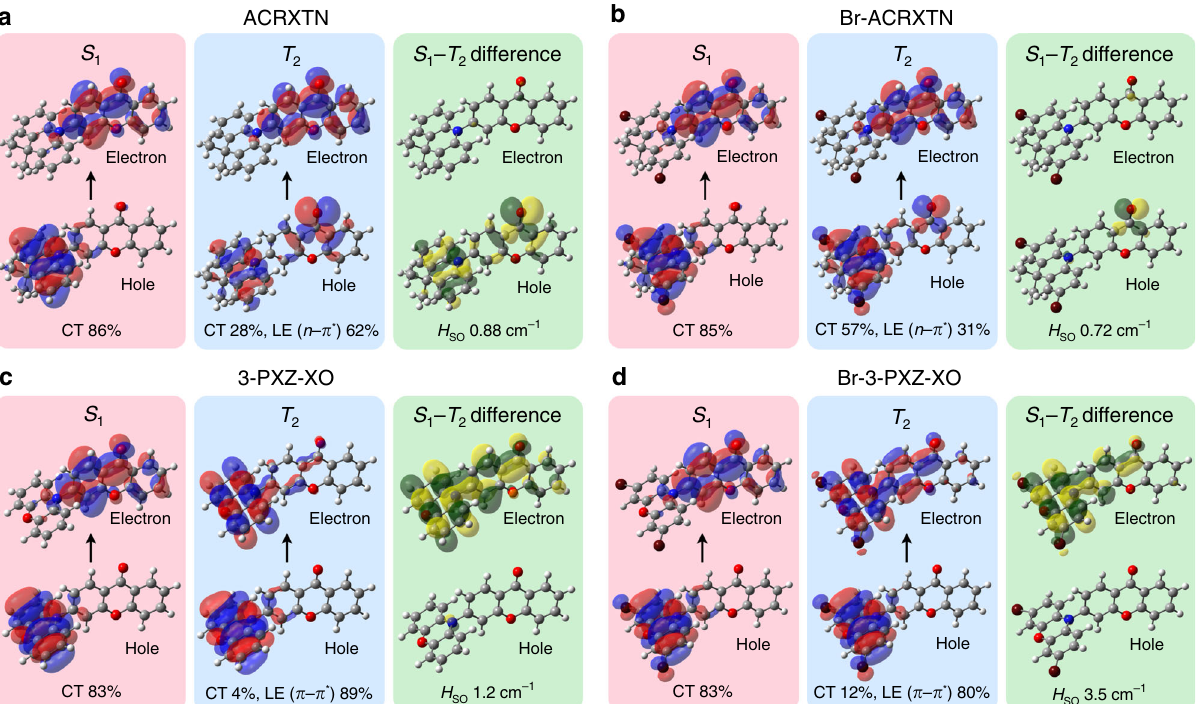
Fig. 4 Electronic con fi gurations of S 1 – T 2 MESXs. a – d Natural transition orbitals (NTOs) for the excited states of ACRXTN ( a ), Br-ACRXTN ( b ), 3-PXZ-XO ( c ), and Br-3-PXZ-XO ( d ) at S 1 – T 2 MESX geometries. The differences in the density of the S 1 and T 2 NTOs are also